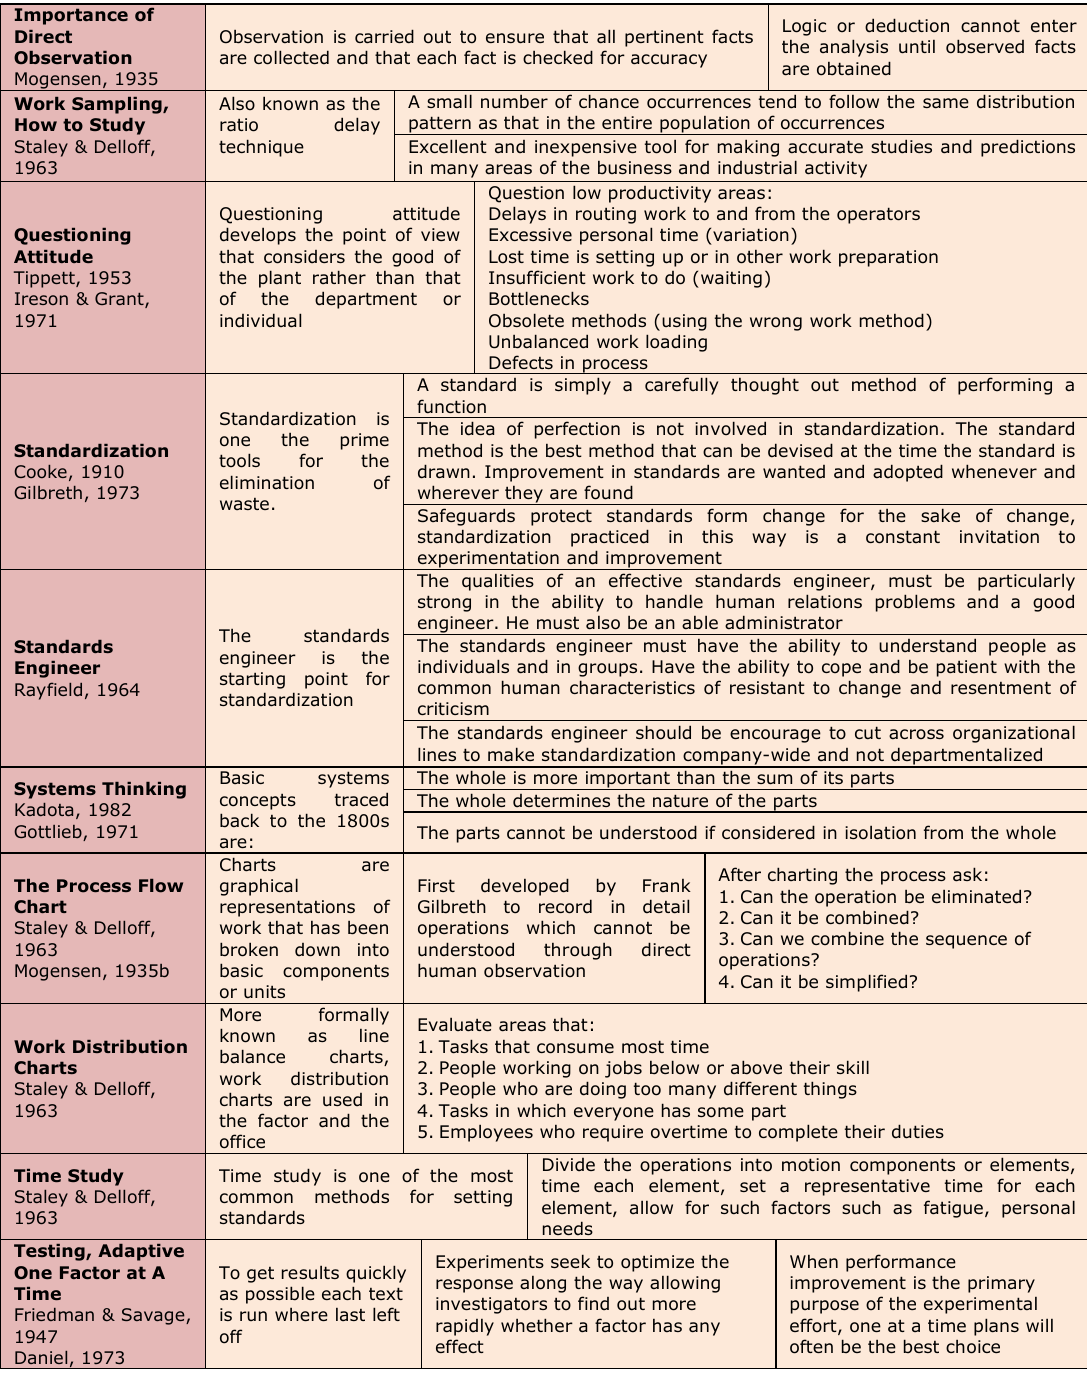
Table 1. Skill sets of industrial engineers in the era of scientific